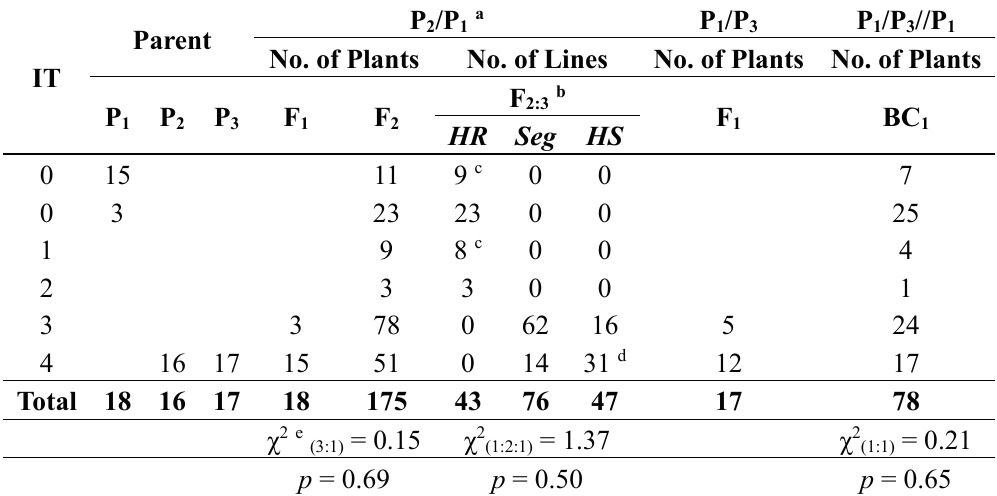
Table 2. Adult plant segregation ratios of powdery mildew response in F 1 , F 2, and BC 1 plants, and F 3 lines when inoculated with Bgt isolate E09.